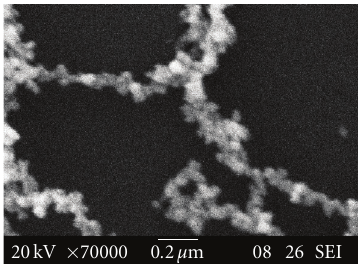
Figure 4: Nanoparticle aggregate